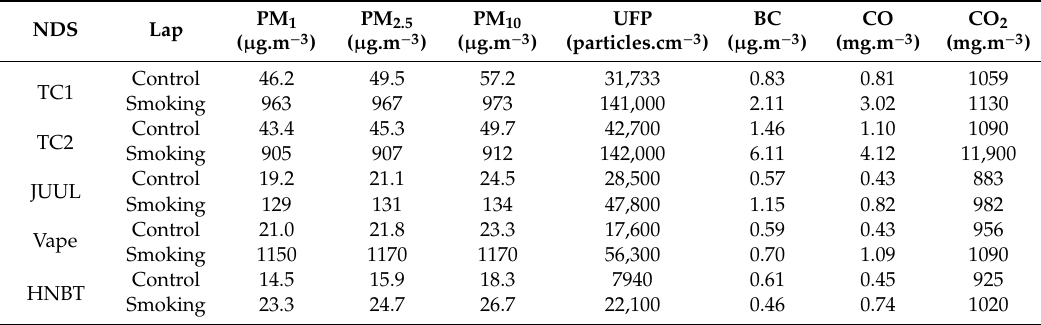
Table 2. Air pollutant average concentrations measured in the car for traditional cigarettes (TC1 and TC2), e-cigarettes (JUUL and Vape) and heat-not-burn tobacco (HNBT).